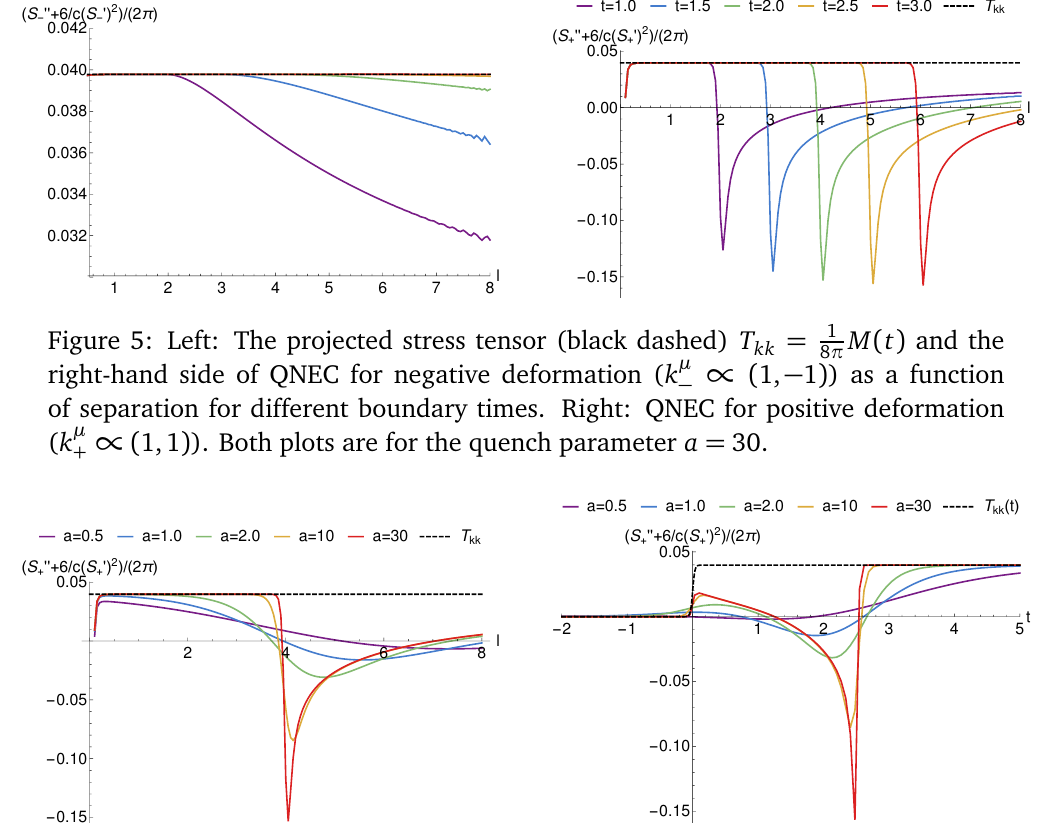
Figure 6: Right-hand side of QNEC for positive deformation ( k a function of separation for different values of a and fixed boundary time t = 2.0. Right: As a function of time, fixed separation l = 5.0 and different values of a